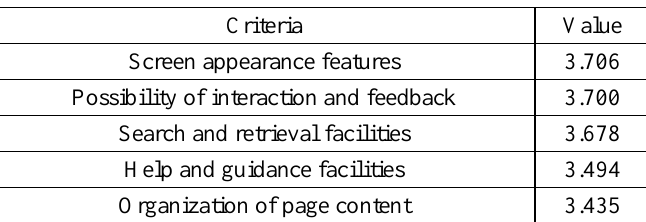
Table 8. Ranking criteria for providing reading services for kids